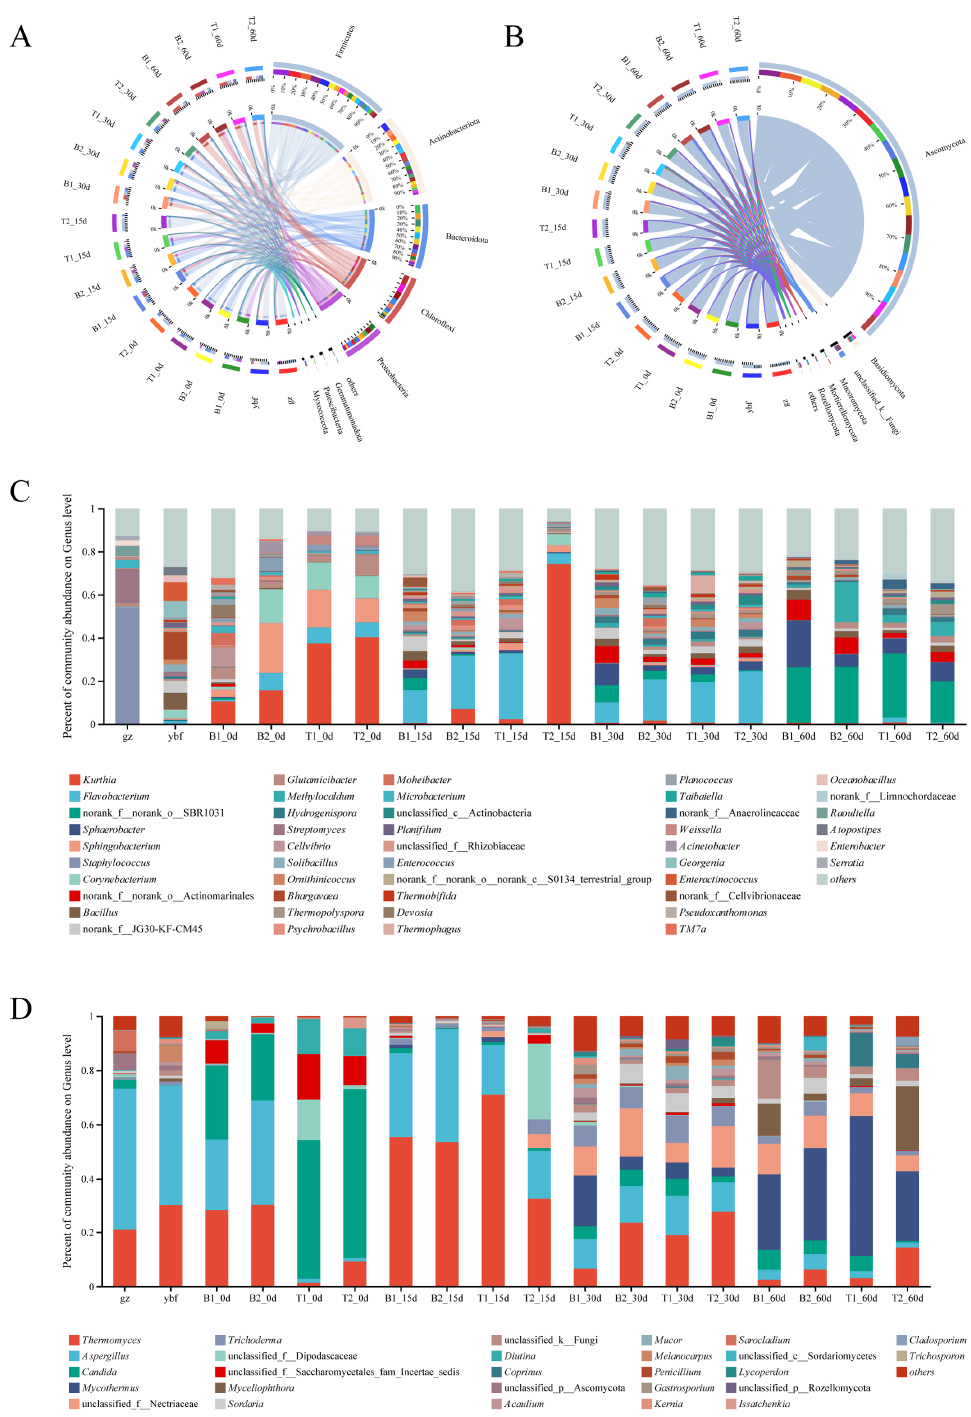
Figure 5. The relative abundance of bacteria at the phylum level ( A ), at the genus level ( B ), and fungi at the phylum level ( C ), at the genus level ( D ) among all samples. Taxa with abundance < 0.01% at the phylum level are classified as “other”, while taxa with abundance < 0.02% at the genus level are classified as “other”. B1, V mushroom residue :V sheep manure = 5:1, with CMA inoculation; B2, V mushroom residue :V sheep manure = 5:1, without inoculation; T1, V mushroom residue :V sheep manure = 9:1, with CMA inoculation; T2, V mushroom residue :V sheep manure = 9:1, without